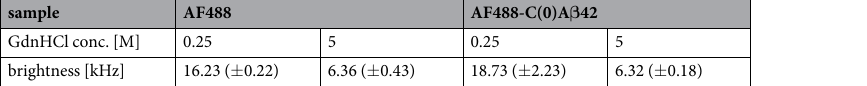
Table 1. Comparison of the brightnesses of free AF488 dye and AF488-C(0)A β 42 in 0.25 M and 5 M GdnHCl solution obtained from PCH analysis (Fig.